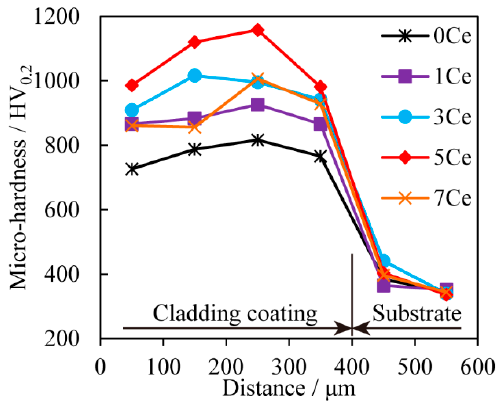
Figure 6. Micro-hardness distribution of the specimens.